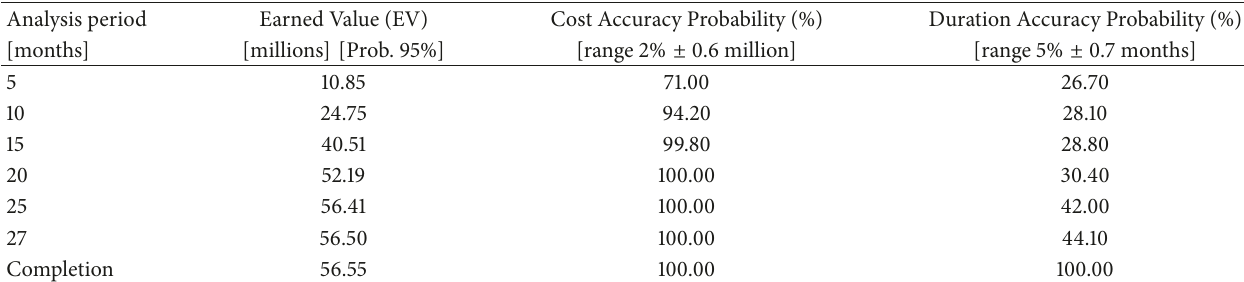
Table 7: Accuracy probability rates in cost forecasts (EVM) and duration forecasts (ES) for the Mazar Dudas project. Analysis period Earned Value (EV) Cost Accuracy Probability